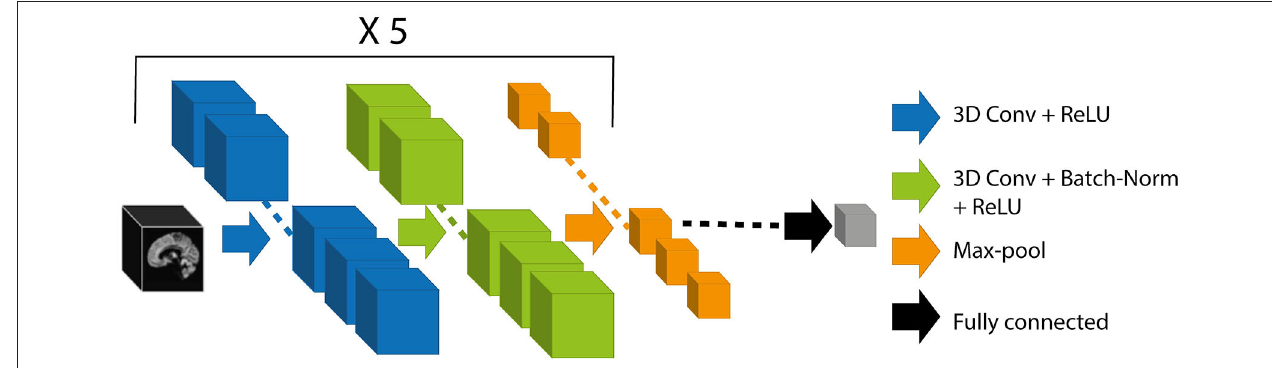
FIGURE 2 | Schematic representation of the CNN architecture. The black box represents the 3D-T1 images as inputs of our model. Each block consisted of 3D convolution of kernel size (3 × 3 × 3), ReLU activation, 3D convolution of kernel size (3 × 3 × 3), batch normalization, rectified linear unit activation, and max-pooling layer of pooling size (2 × 2 × 2). The block was repeated 5 times. The output of the network (gray box) corresponds to the brain-predicted age. CNN, convolutional neural network; ReLU, Rectified Linear Unit.